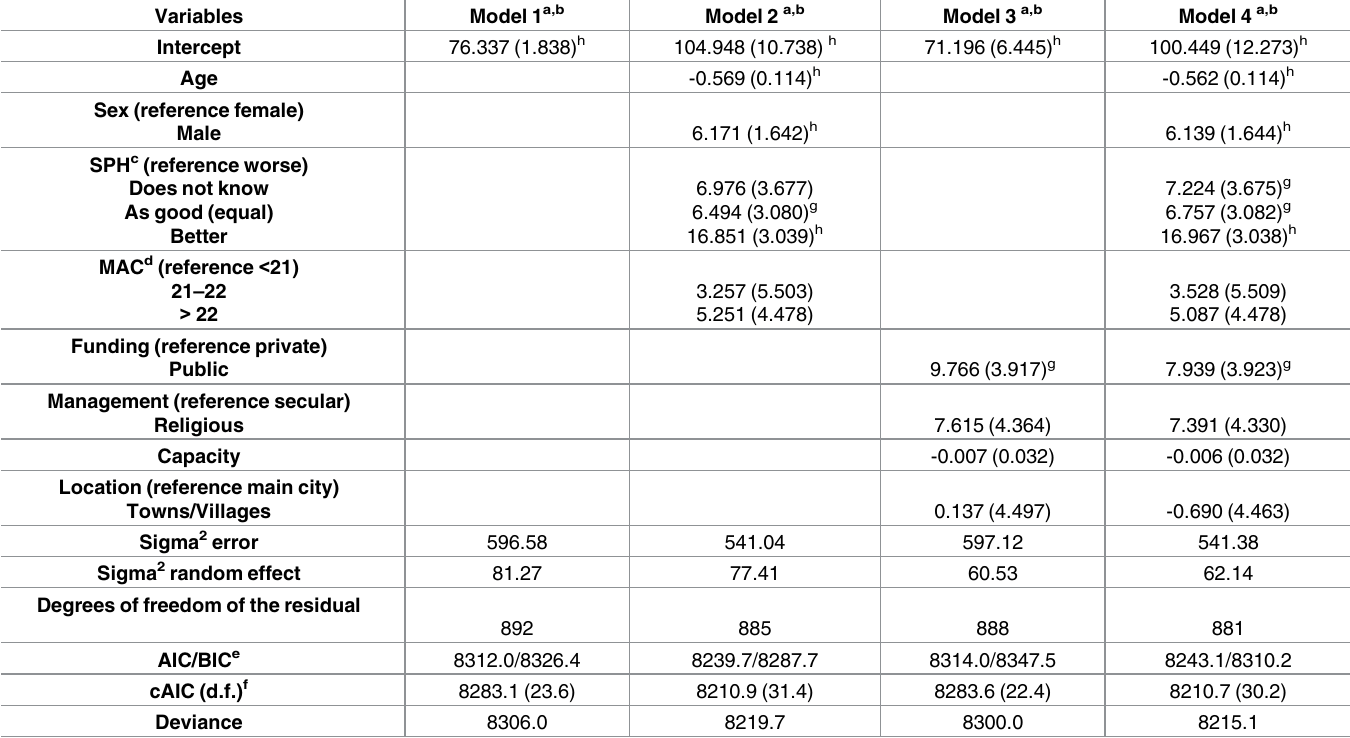
Table 2. Results for the four multilevel models fitted to the data in the study.